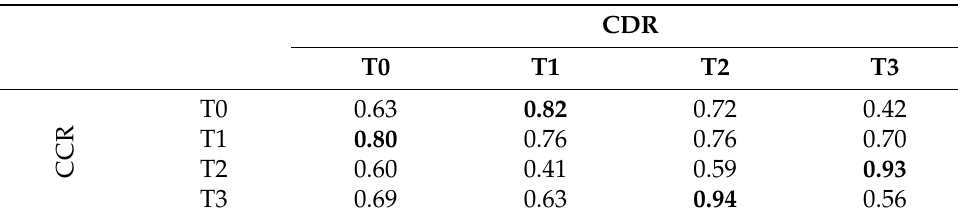
Table 1. Cosine similarity between topics discovered over CCR and CDR data [26] in the Santiago City area. Bold numbers are maximal values per